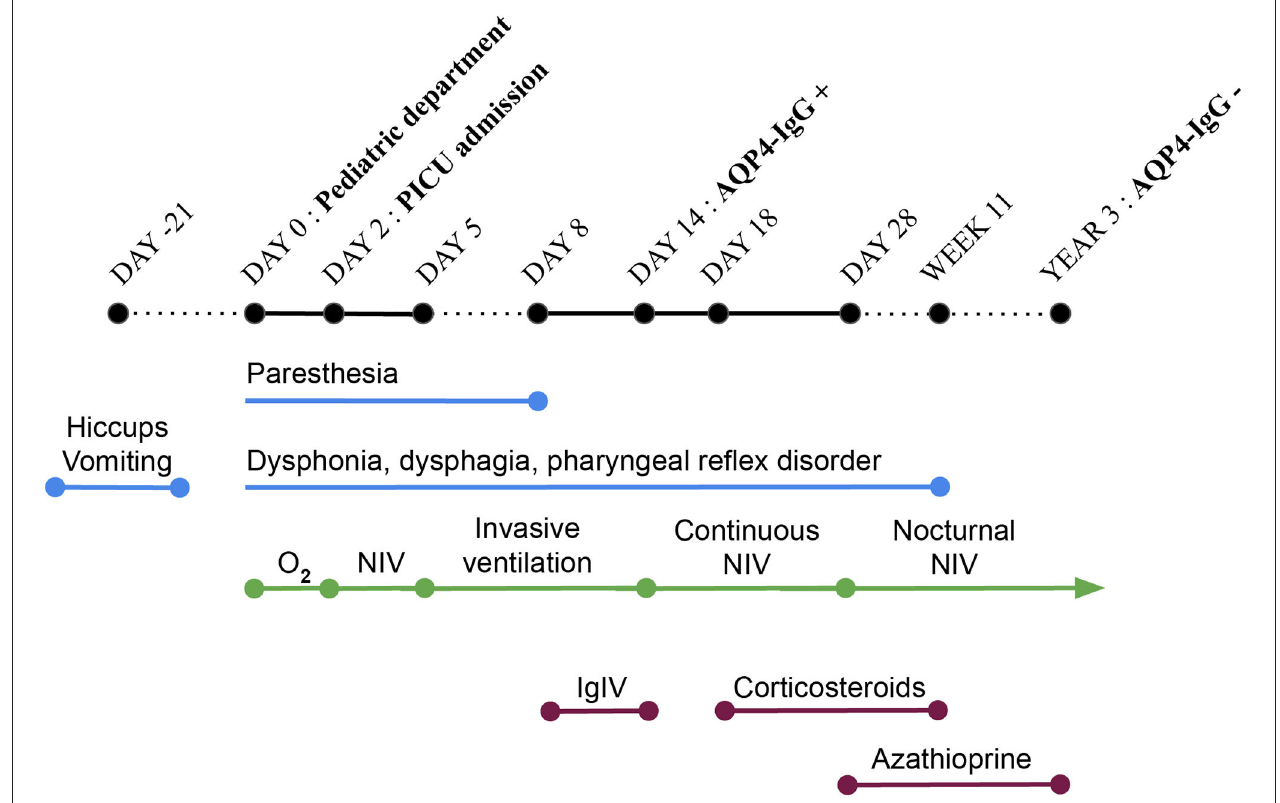
FIGURE 1 | Timeline. PICU, pediatric intensive care unit; O 2 , oxygen; NIV, non-invasive ventilation; IgIV, intravenous immunoglobulin therapy; AQP-IgG, autoantibodies against the aquaporin-4 water